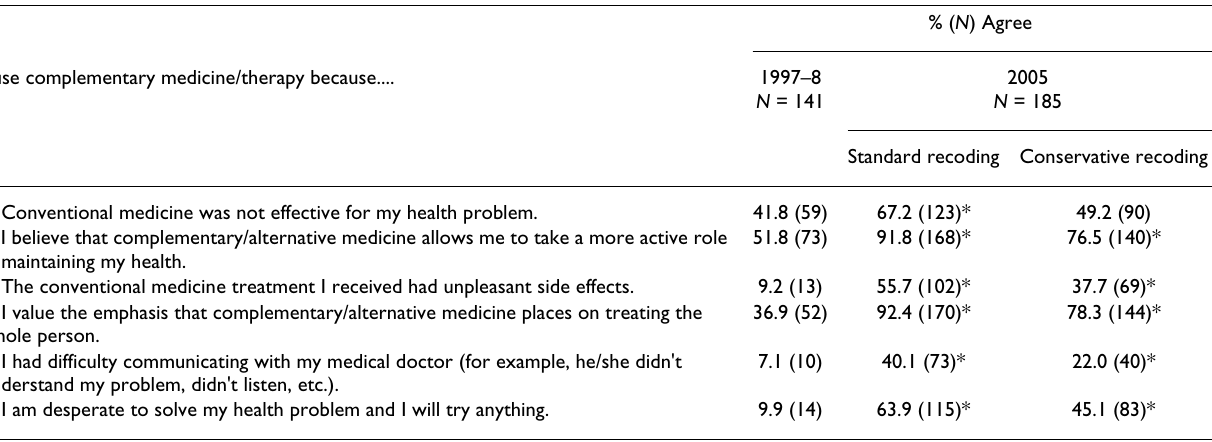
Table 3: Reasons for using CAM in 1997–8 compared to 2005 I use complementary medicine/therapy